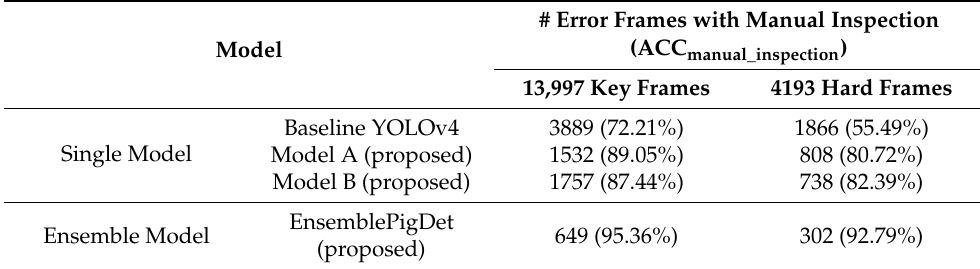
Table 5. Comparison of accuracy ACC manual_inspection for 13,997 key frames and 4193 hard